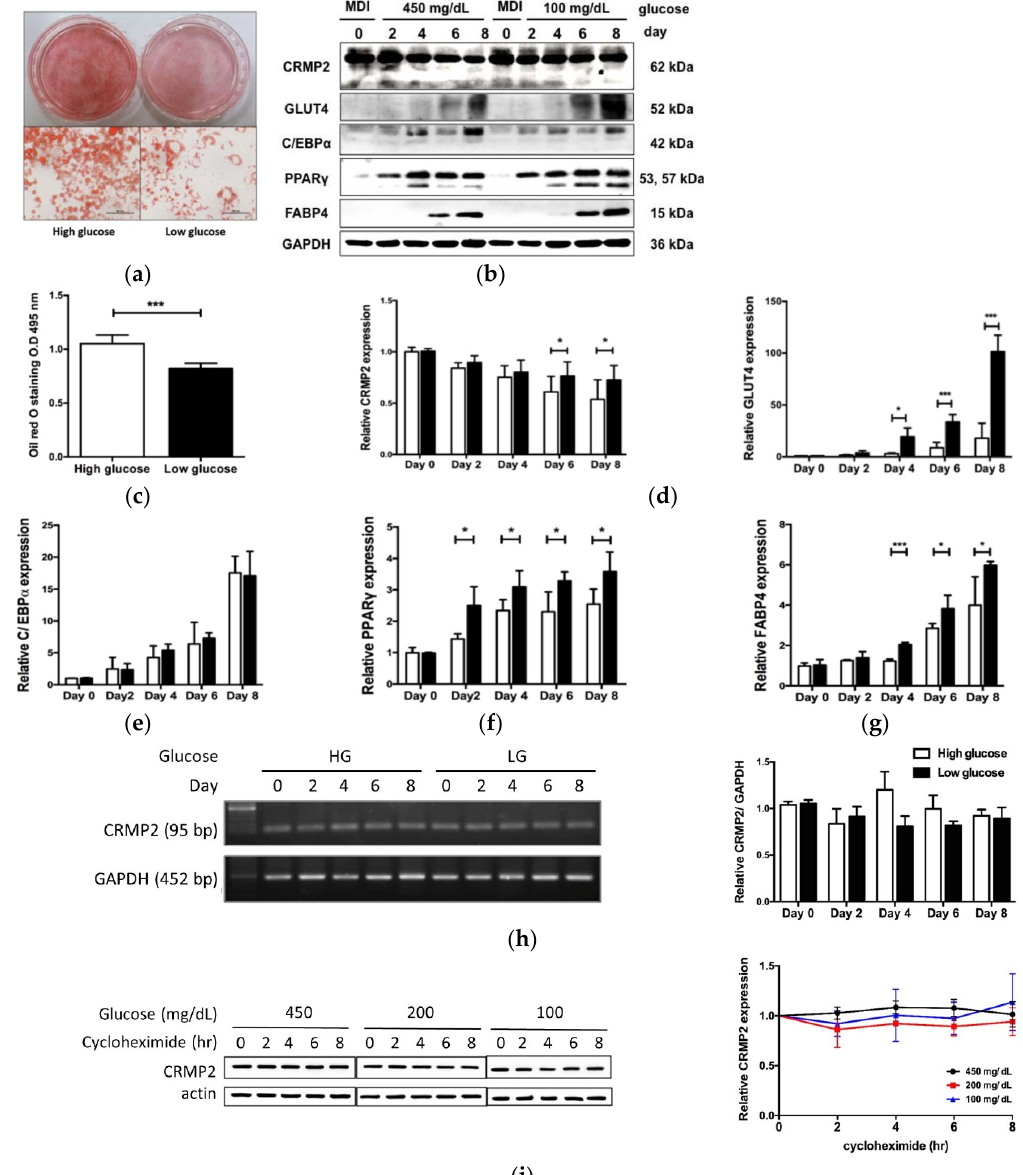
Figure 5. Effects of glucose on CRMP2 and adipogenic machinery. Cells were induced into differ- entiation in culture media containing either high (white bars) or low (black bars) glucose ( n = 5). ( a ) Differentiation efficiency were determined by ORO staining, scale bar = 50 µ m. ( b ) CRMP2 and important adipogenic proteins were analyzed by Western blotting. ( c – g ) Quantitative results of ( b ). ( h ) CRMP2 mRNA was analyzed by RT-PCR. ( i ) On day 4, cells were serum starved for 16 h, followed by cycloheximide (10 µ g/mL) treatment and Western blotting ( n = 3). * p < 0.05, *** p < 0.005 vs.